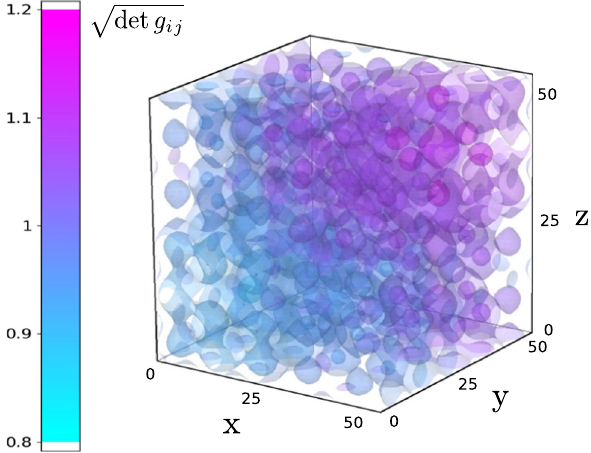
Fig. 4 The dependence of the density contrast in time. Blue curve (cid:20) Fig. 2 The isosurfaces of the geometrical factor corresponds to K = 0, orange refers to K = 0 . 1 and light green to det g i j appearing in (cid:20) K = − 0 . the volume element det g i j d 3 x . The domain is the elementary cell